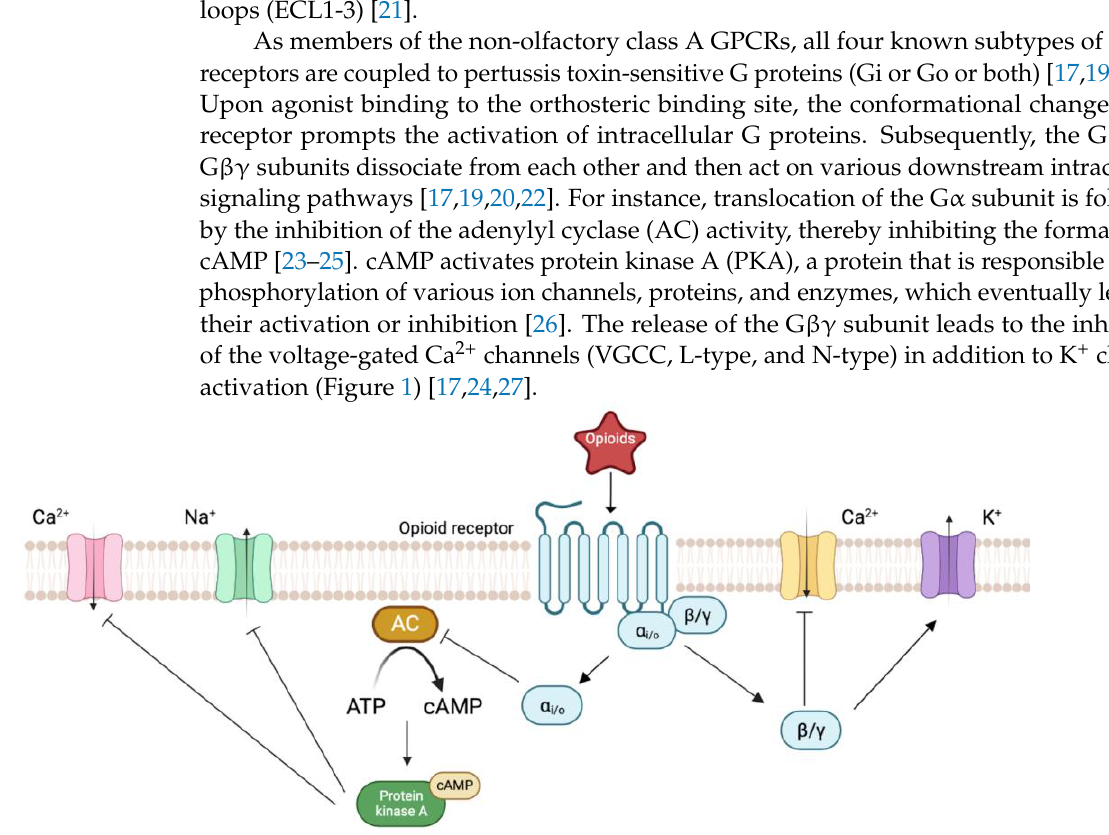
Figure 1. The signal transduction pathway of the opioid receptor. Upon agonist binding, the opioid receptor couples with the heterotrimeric G protein that later dissociates into G α and G βγ subunits, followed by the translocation of the G α subunit that leads to the inhibition of the adenylyl cyclase (AC) activity. The release of G βγ subunit inhibits voltage-gated Ca 2+ channels (VGCC, L-type, and N-type) and causes activation of K + channels.